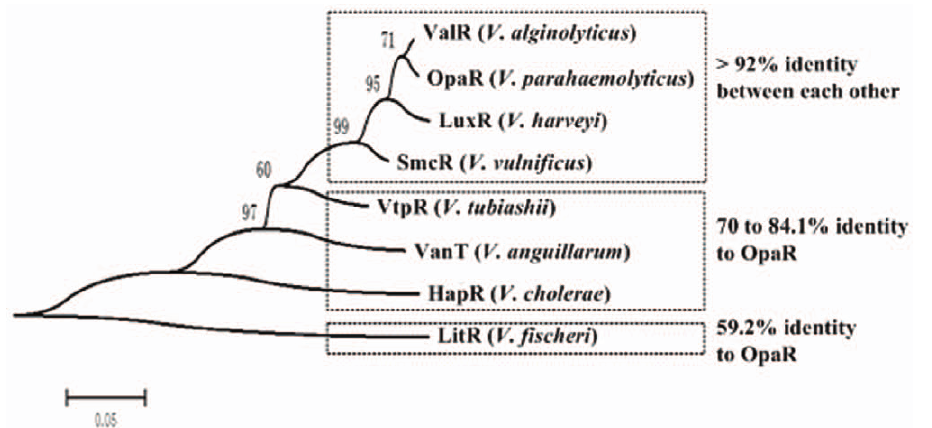
Figure 2. Phylogenetic tree of OpaR and its orthologs. Protein sequences were derived from V. alginolyticus ZJ-51 [60], V. parahaemolyticus RIMD 2210633 [16], V. harveyi ATCC BAA-1116 [61], V. vulnificus YJ016 [62], V. tubiashii RE22 [63], V. anguillarum 775 [64], V. cholera N16961 [65], and V. fischeri MJ11 [66]. The a.a. sequences were aligned by the CLUSTALW [67] web server at http://align.genome.jp/. The aligned sequences were then used to construct an unrooted neighbor-joining tree using the MEGA version 5.0 [68] with a bootstrap iteration number of 1000. Shown on the branch points of phylogenic tree were the bootstrap values (%).